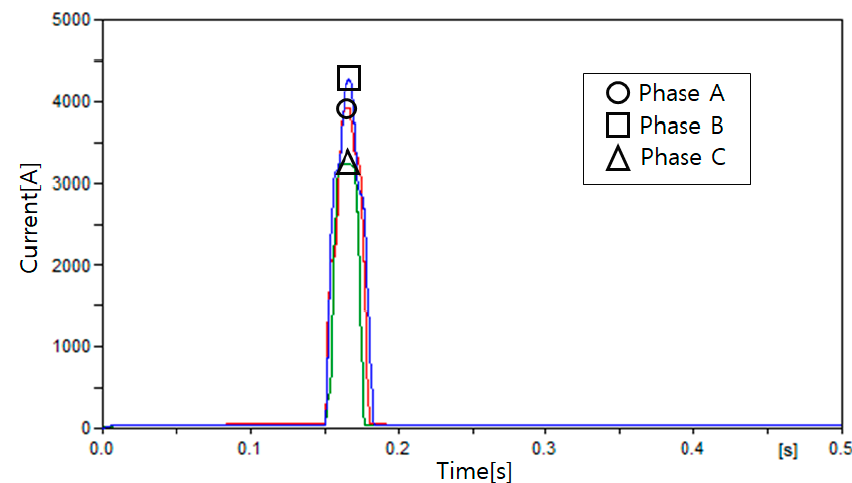
Figure 10. Fault location in Case 2.